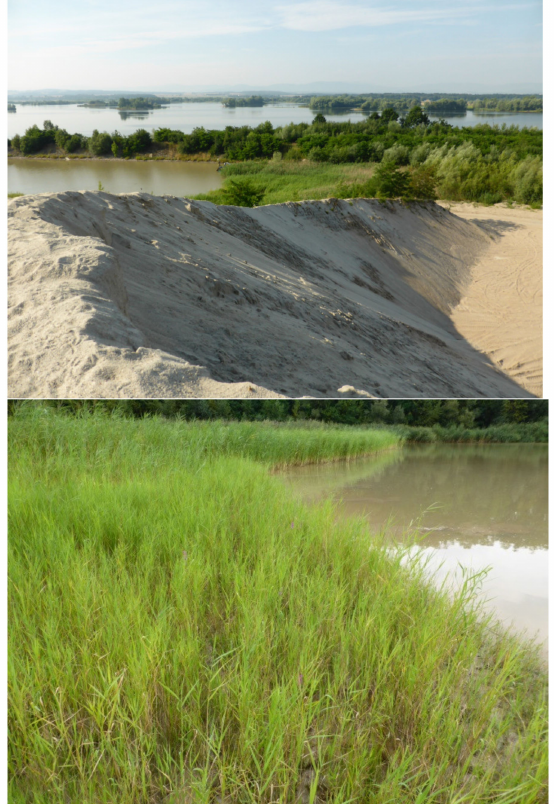
Figure A3. Two extreme habitats: sand heaps and wetlands on the territory of the open cast